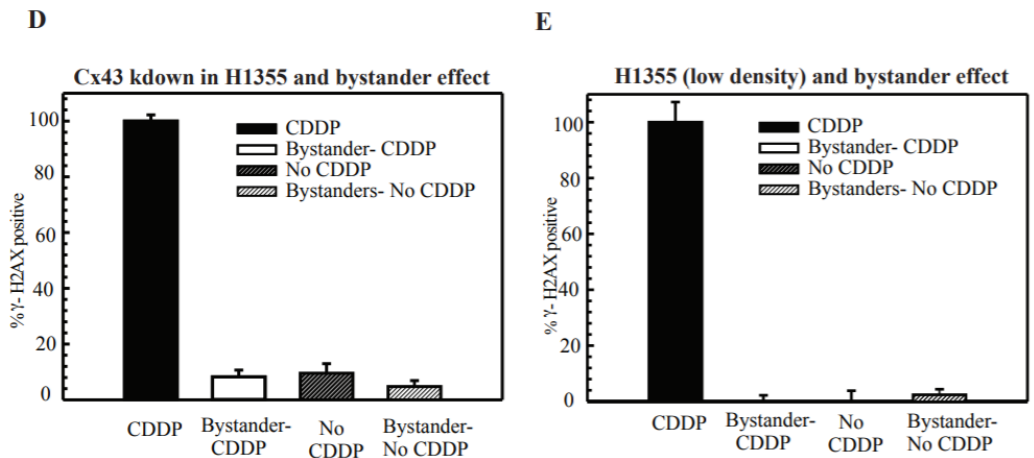
Figure 4. Positive γ -H2AX foci indicating DNA DSB formation in bystander cells post-cisplatin treatment. ( A ) H1355 and ( B ) A2780 cells were divided into 2 populations—labeled with vital cell tracker dye or left unstained. Labeled cells were either treated or left untreated (control) to cisplatin (CDDP) and then mixed with unstained untreated cells and then visualized for positive γ -H2AX foci by immunostaining. Values are represented as percent above background ± S.D. from 3 independent experiments. ( C ) Representative image from H1355 cells. Left panel is without cisplatin/vehicle while right panel is cisplatin treated. Blue—DAPI, red/orange—cell tracker orange, green— γ -H2AX foci merged. ( D , E ) DSB formation in H1355, Cx43 knockdown cells ( D ) and cells plated at colony density ( E ). In both cases, cell were divided into 2 populations—labeled with vital cell tracker dye or left unstained. Labeled cells were either treated or left untreated (control) to cisplatin and then mixed with unstained untreated cells and then visualized for positive γ -H2AX foci by immunostaining. Values are represented as percent above background ± S.D. from 3 independent experiments.